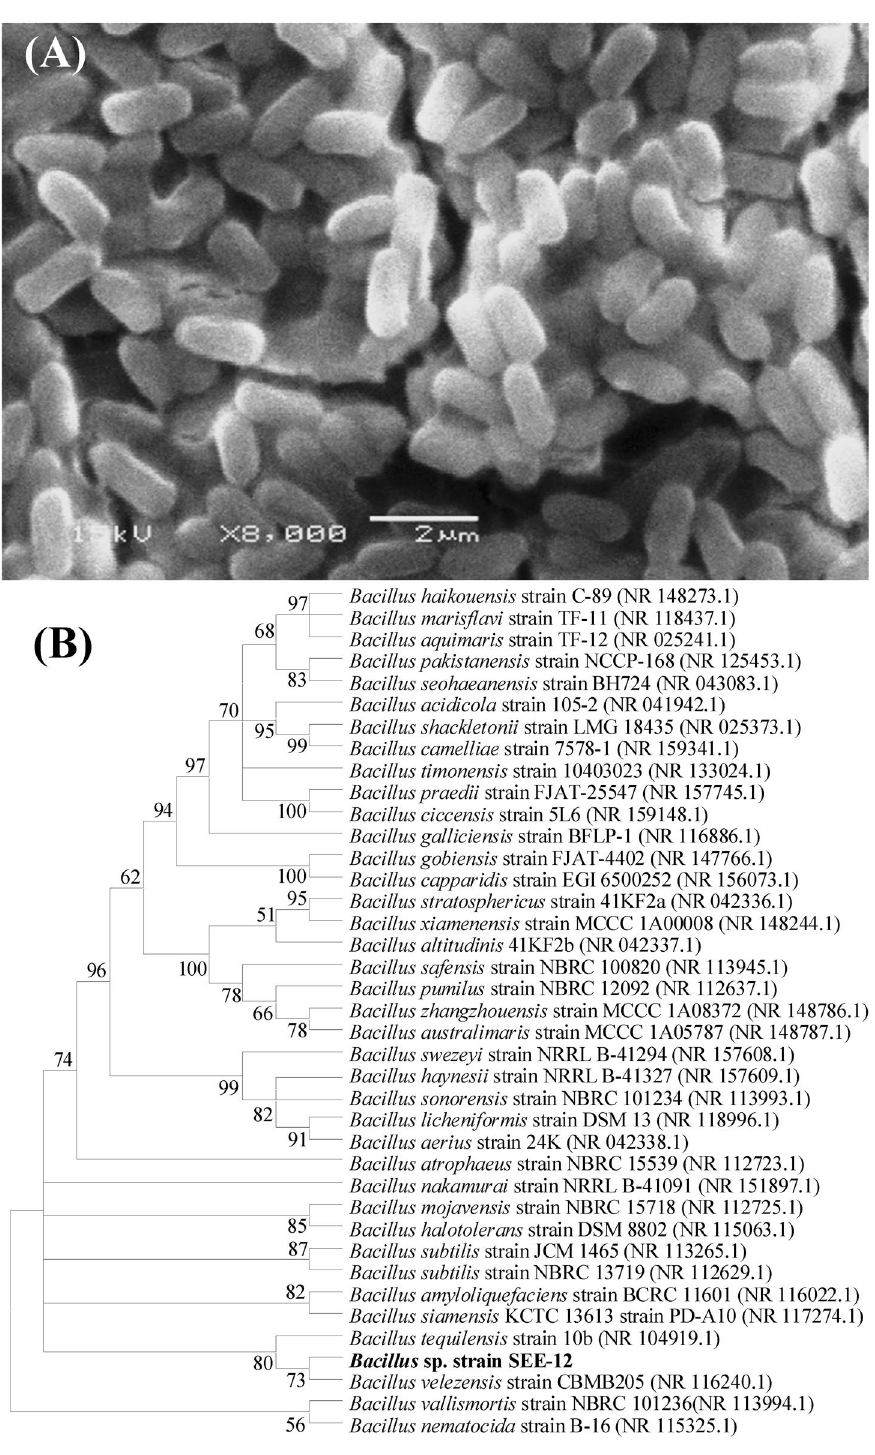
Figure 2. ( A ) Scanning electron micrograph showing cell morphology of strain SEE-12 at magnification of 8000 X, ( B ) The neighbor-joining algorithm phylogenetic tree of strain SEE-12 and related species of the genus Bacillus